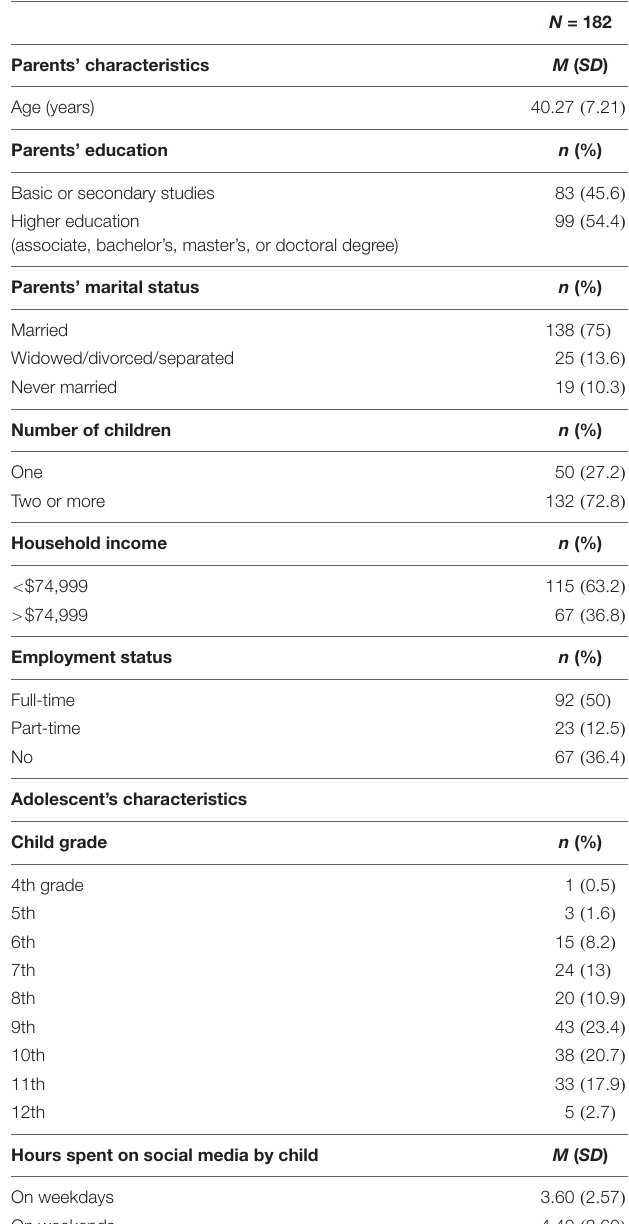
TABLE 1 | Demographic characteristics of the